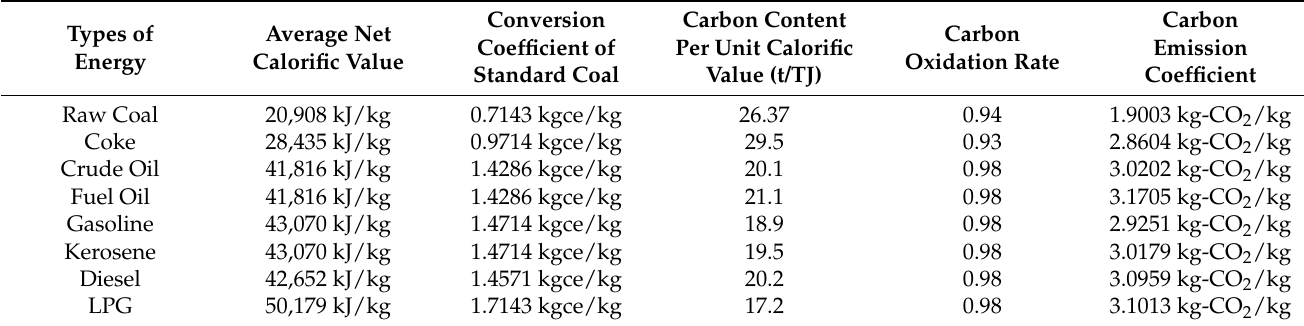
Table 1. Carbon emissions factors for each type of